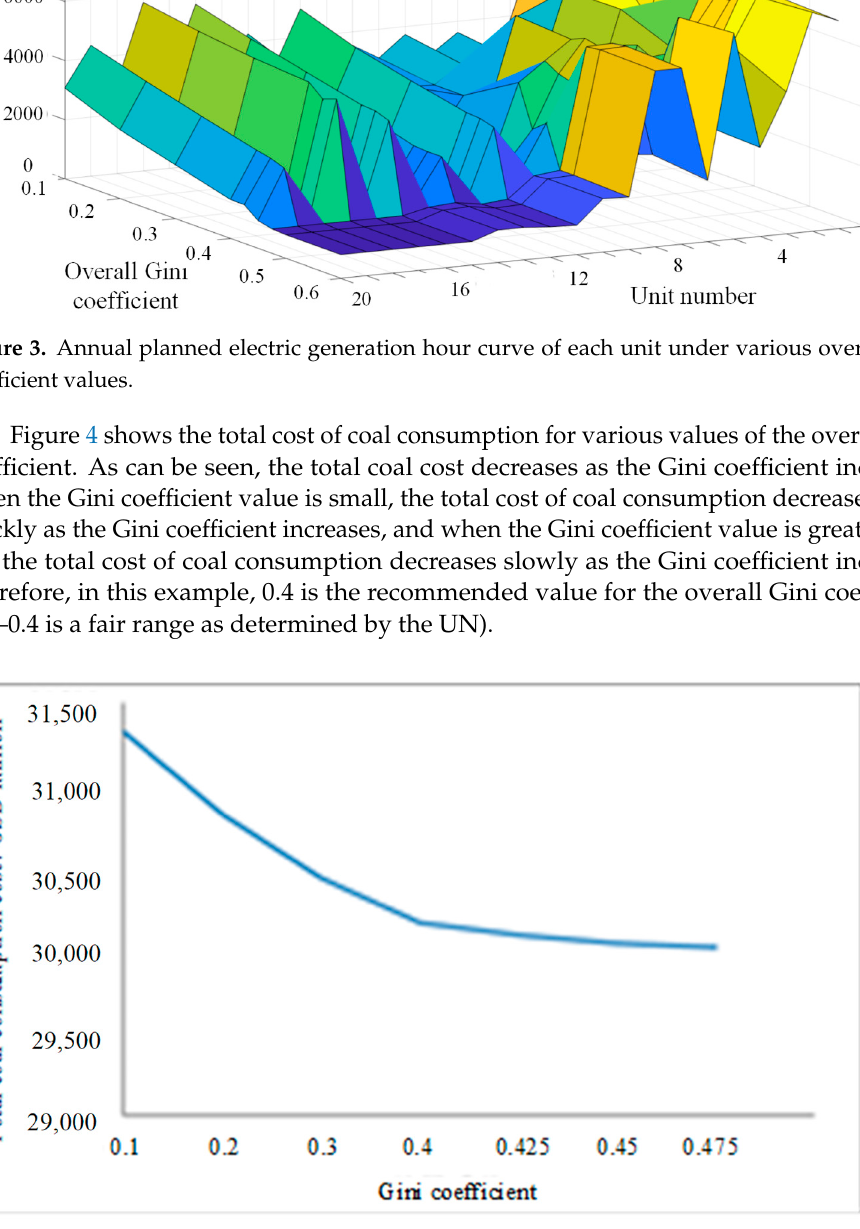
Figure 4. The total coal consumption cost curve under various overall Gini coefficient values.